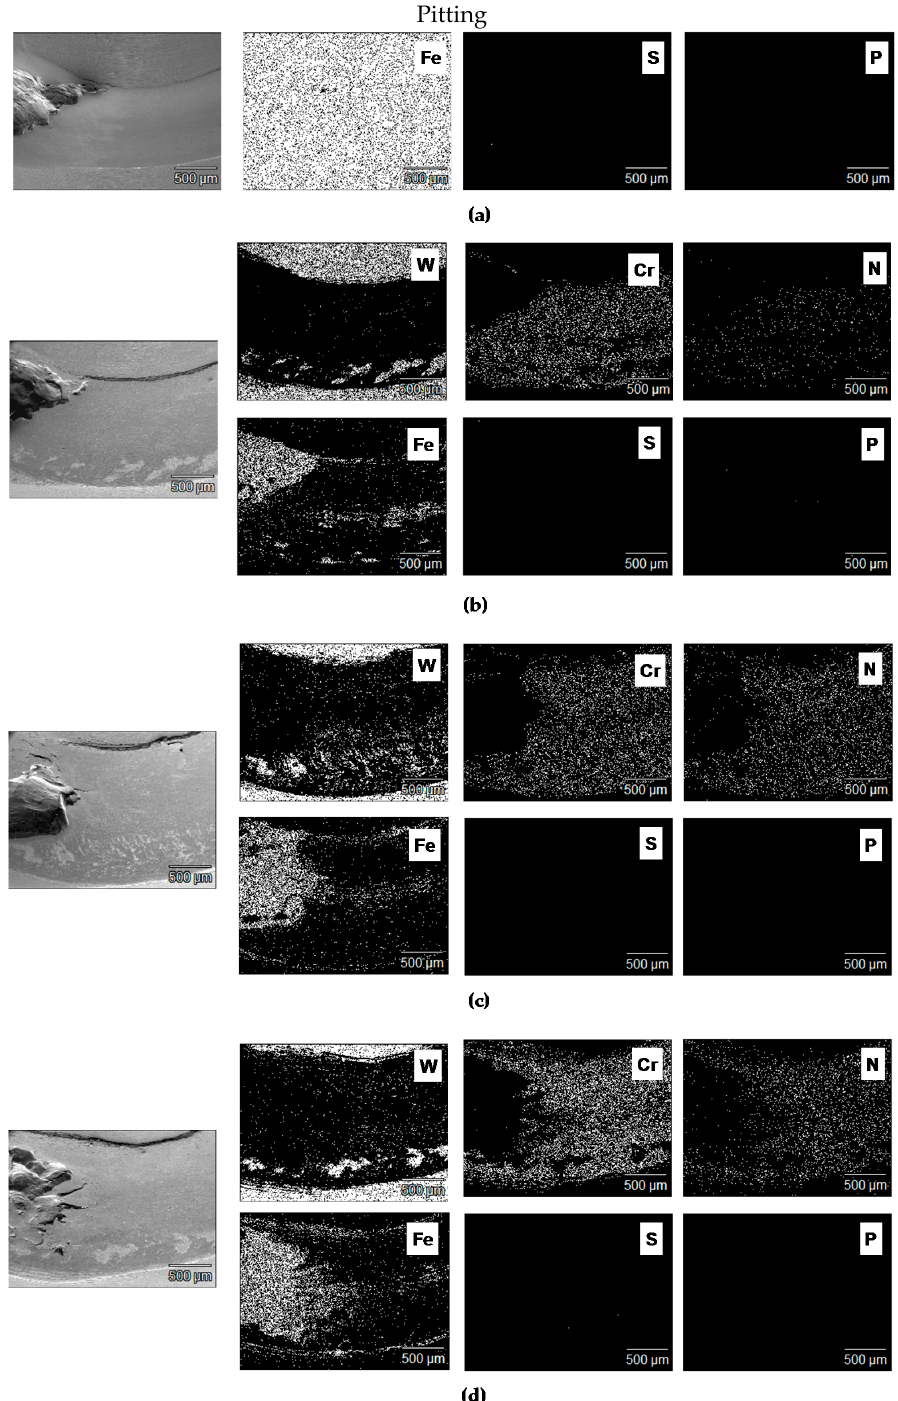
Figure 17. SEM images (on the left) and EDS surface analyses of the wear tracks on the test cones: ( a ) Uncoated cone lubricated with the mineral oil; ( b ) (W-DLC/CrN)-coated cone lubricated with the mineral oil; ( c ) (W-DLC/CrN)-coated cone lubricated with the PAO oil; and ( d ) (W-DLC/CrN)-coated cone lubricated with the PAG oil.